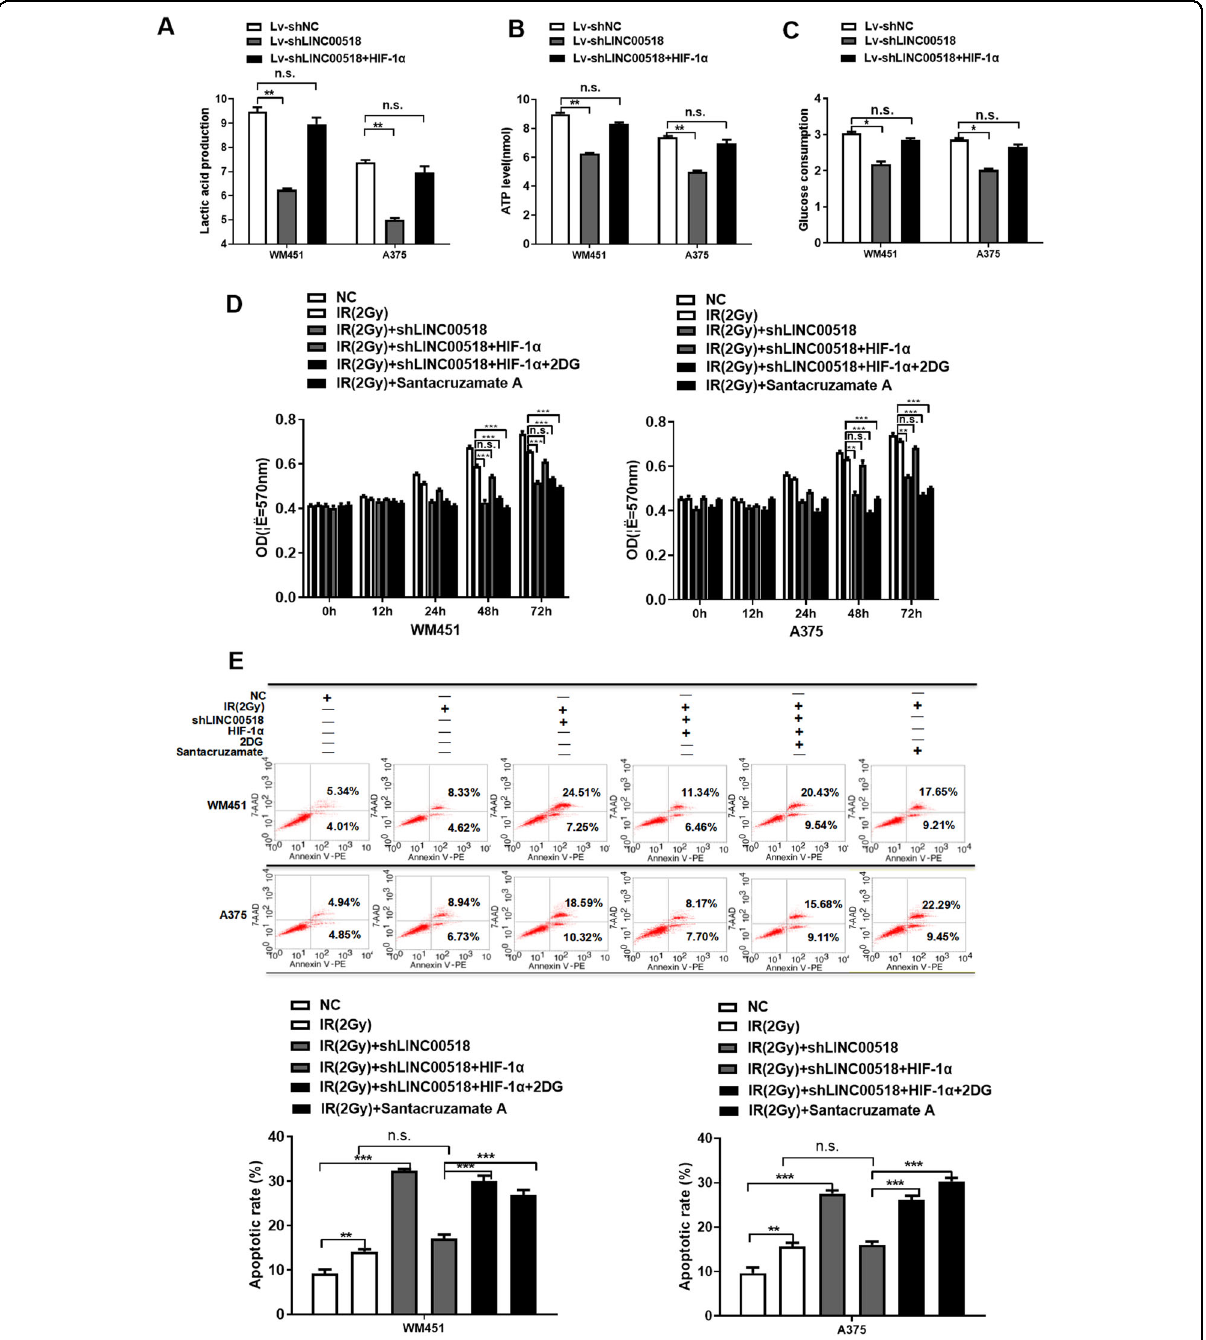
Fig. 6 Involvement of the LINC00518 – miR-33a-3p – HIF-1 α negative feedback loop in glycolysis-mediated radiotherapy resistance of CMM cells. A – C The levels of glucose consumption and lactate production were estimated in CMM cells. These results indicated that knockdown of LINC00518 expression in WM451 and A375 cells decreased glucose consumption, ATP levels, and lactic acid production in the cells; by contrast, overexpression of HIF-1 α signi fi cantly reversed the effects of LINC00518 silencing on glycolytic tumor metabolism in WM451 and A375 cells. D Detection of CMM cell sensitivity to radiotherapy after LINC00518 knockdown by using an MTT assay. LINC00518 knockdown in CMM cells could inhibit their proliferation after the use of radiotherapy and HIF-1 α could reverse this effect, while 2DG and Santacruzamate A offset the in fl uence of HIF- 1 α . E Flow cytometry examination of the effect of radiotherapy on CMM cell apoptosis following LINC00518 knockdown. LINC00518 knockdown in CMM cells could increase apoptosis after using radiotherapy and HIF-1 α could reverse this effect, while 2DG and Santacruzamate A offset the in fl uence of HIF-1 α . The histogram data for each group are an average of three independent replicates; bars indicate SD; * P < 0.05, ** P < 0.01, *** P <